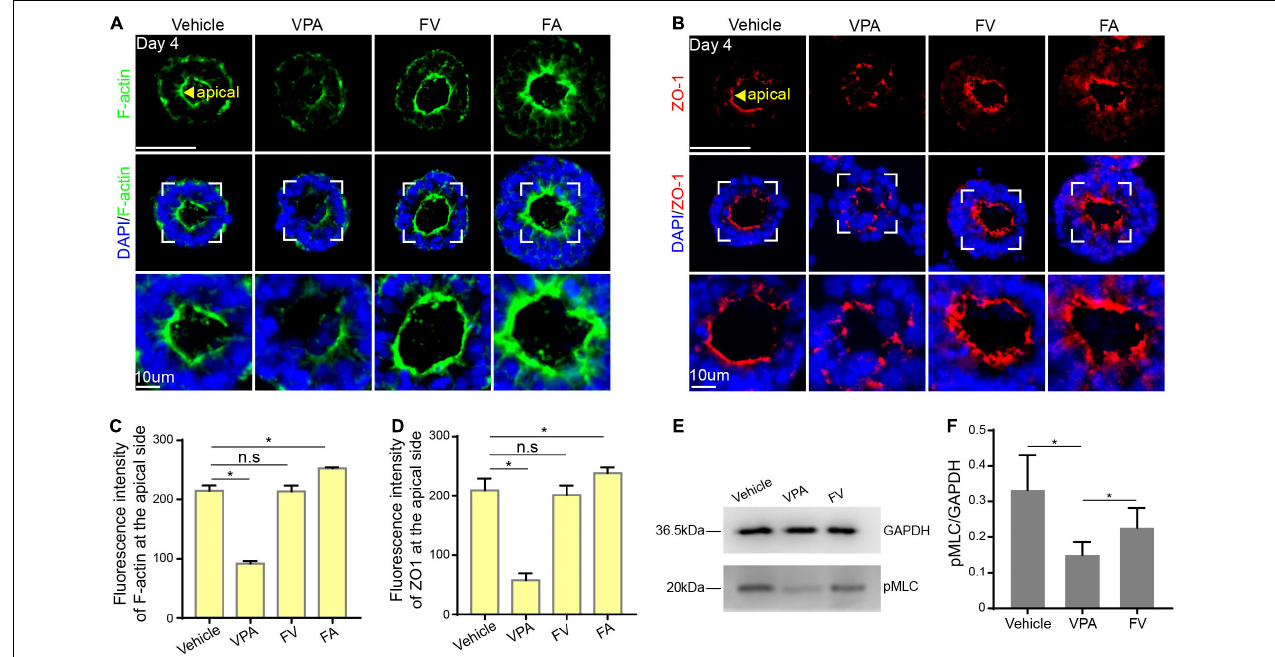
FIGURE 6 | FA rescued VPA-induced morphogenesis inhibition. (A,C) The expression of F-actin at the apical domain in control, VPA1 µ M, FV and FA10 µ M group. (B,D) The expression of ZO-1 at the apical domain in control, VPA1 µ M, FV, and FA10 µ M group. (E) Western blot of pMLC in control, VPA1 µ M, FV group. (F) Quantification of triplicate experiments. Scale bars: 50 µ m. * P <